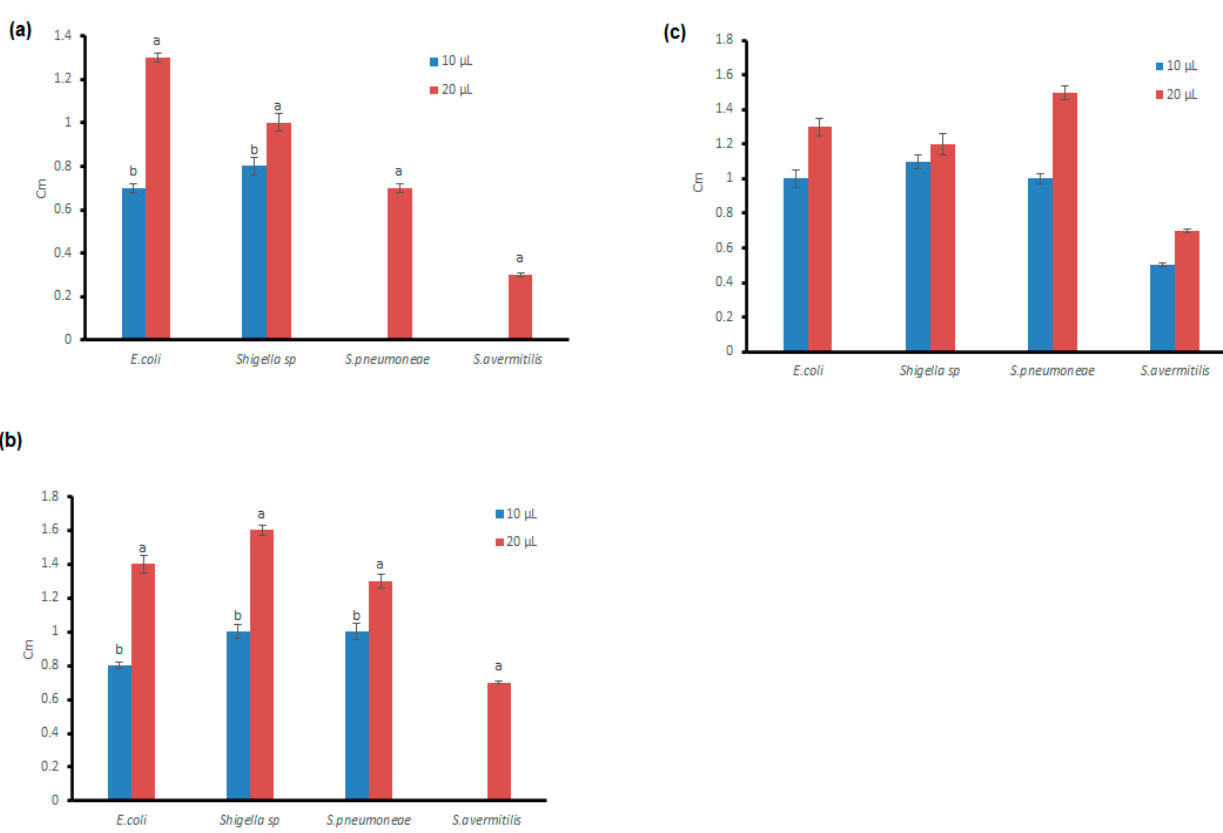
Figure 3. Antibacterial activity of the ethyl acetate (extracellular) extract of ( a ) Cladosporium cladosporioides, ( b ) Graminicolous helminthosporium, and ( c ) Bipolaris australiensis against various bacterial pathogens. Data are represented as means ± SD of three replicates. If followed by different letters, the results are significantly different according to Duncan’s multiple range test at p ≤